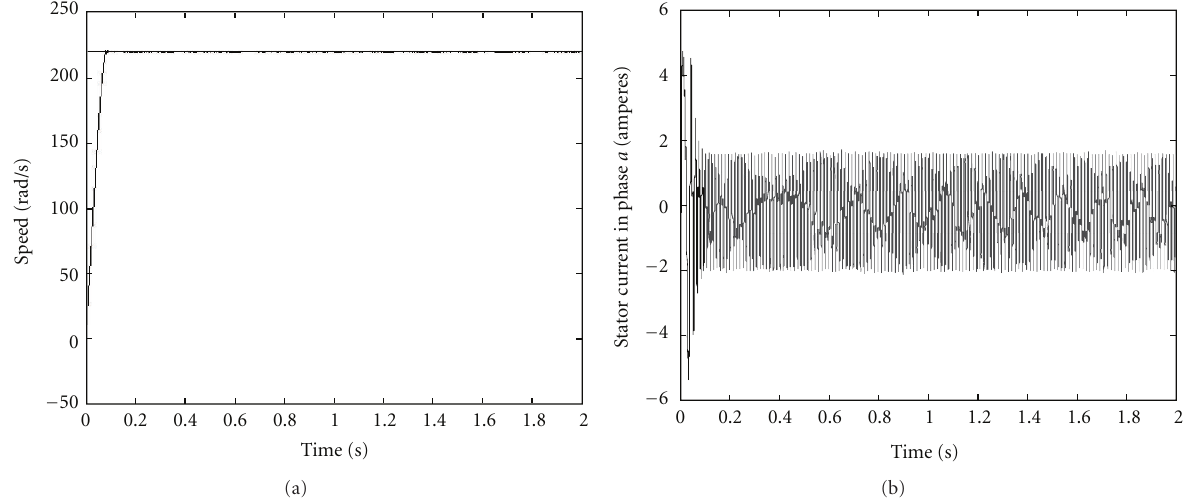
Figure 6: (a) Simulated speed of IPMSM drive for flux-weakening control with reference speed 220 rad/s using fuzzy controller. (b) Simulated current of IPMSM drive for flux-weakening control with reference speed 220rad/sec using fuzzy controller.